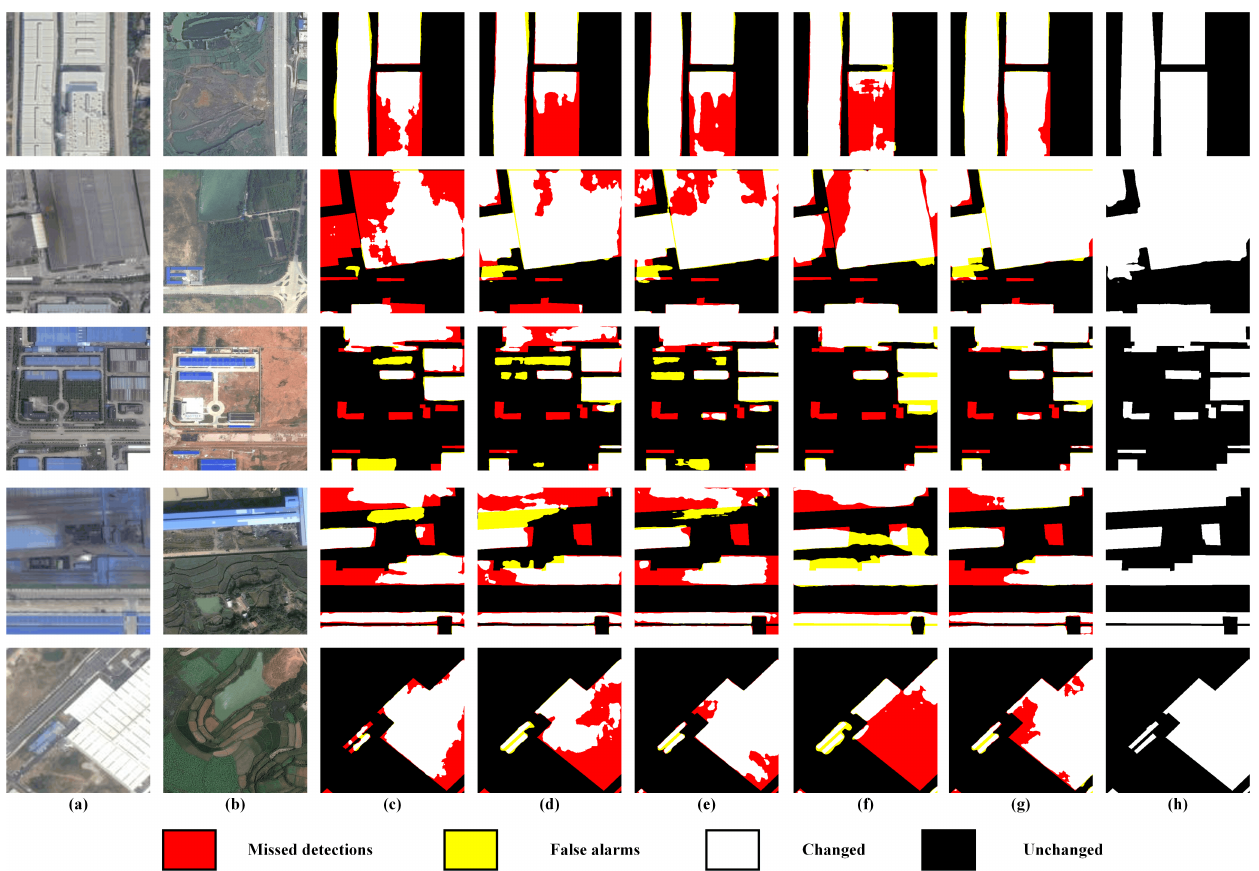
Figure 11. Visual performance of CD results based on different super-resolution methods. ( a ) Image T1 (LR, resized to the size of the HR). ( b ) Image T2 (HR). ( c ) Bicubic-CD. ( d ) EDSR-CD. ( e ) WDSR-CD. ( f ) CTN-CD. ( g ) Proposed RACDNet. ( h )